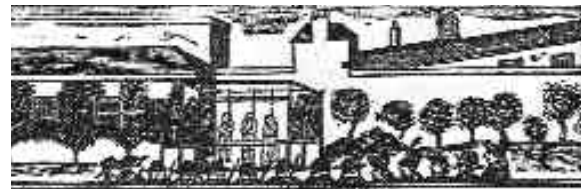
Fig. 1. Woodcut depicting a triple hanging at